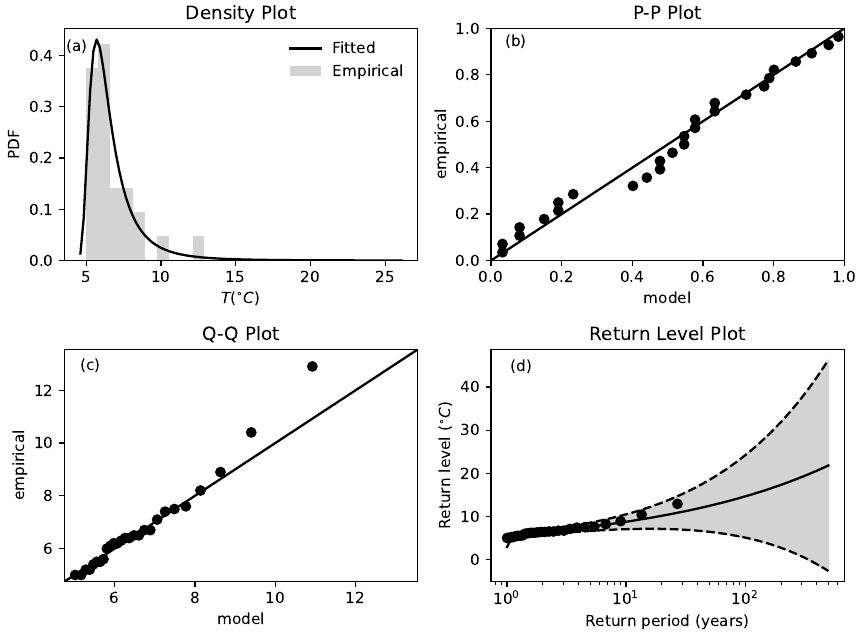
Figure 8. ( a ) Density plot, ( b ) probability plot, ( c ) quantile plot, ( d ) return level plot for the annual maximum temperature values at Arturo Prat